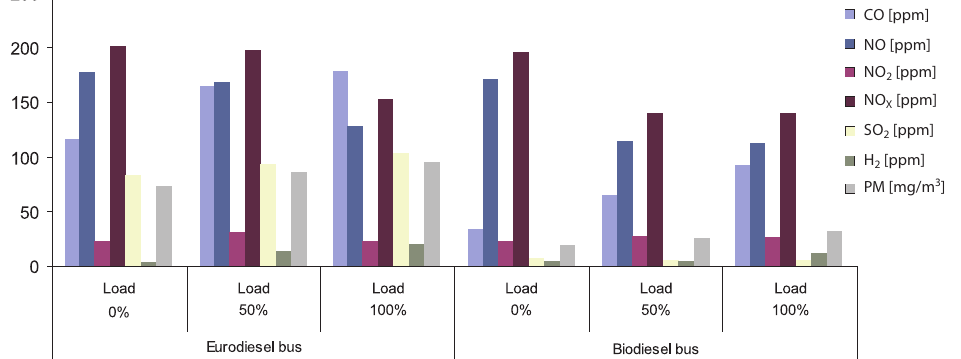
Fig. 2. The emission of toxic gases of buses running on mineral diesel and